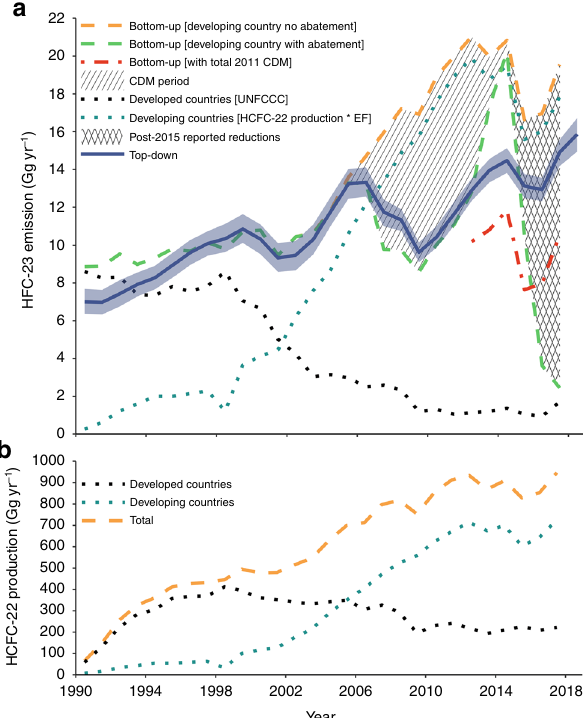
Fig. 1 Global HFC-23 emissions and HCFC-22 production. a Top-down global HFC-23 emissions (blue line) and uncertainties (blue shaded area; 1 σ , incorporating uncertainties due to the prior constraints, measurements, model representations of the data, calibration scale and HFC-23 lifetime,